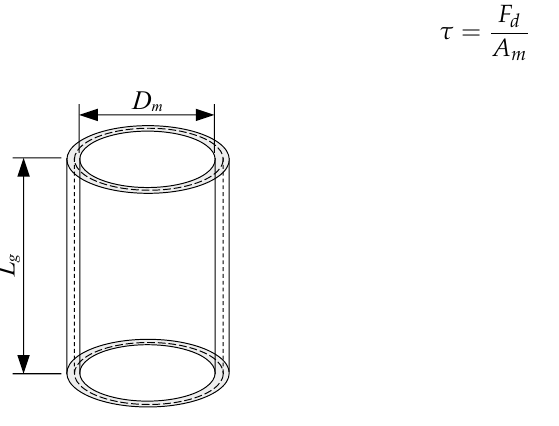
Figure 6. Shear gap, D m —circumferential diameter, L g —gap